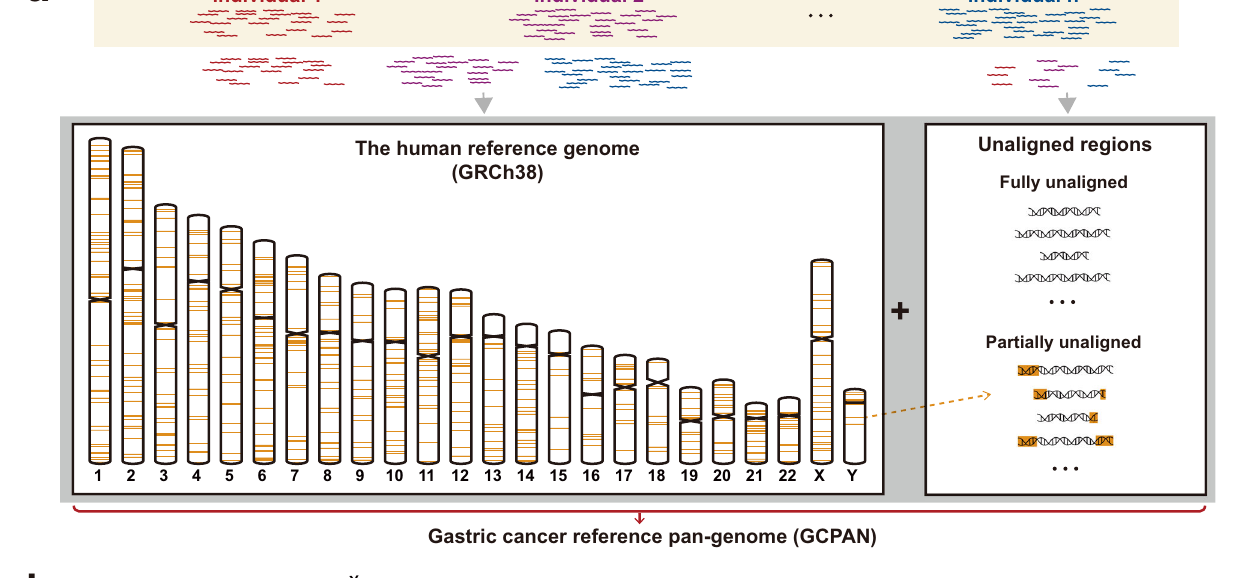
One-end placed novel sequences